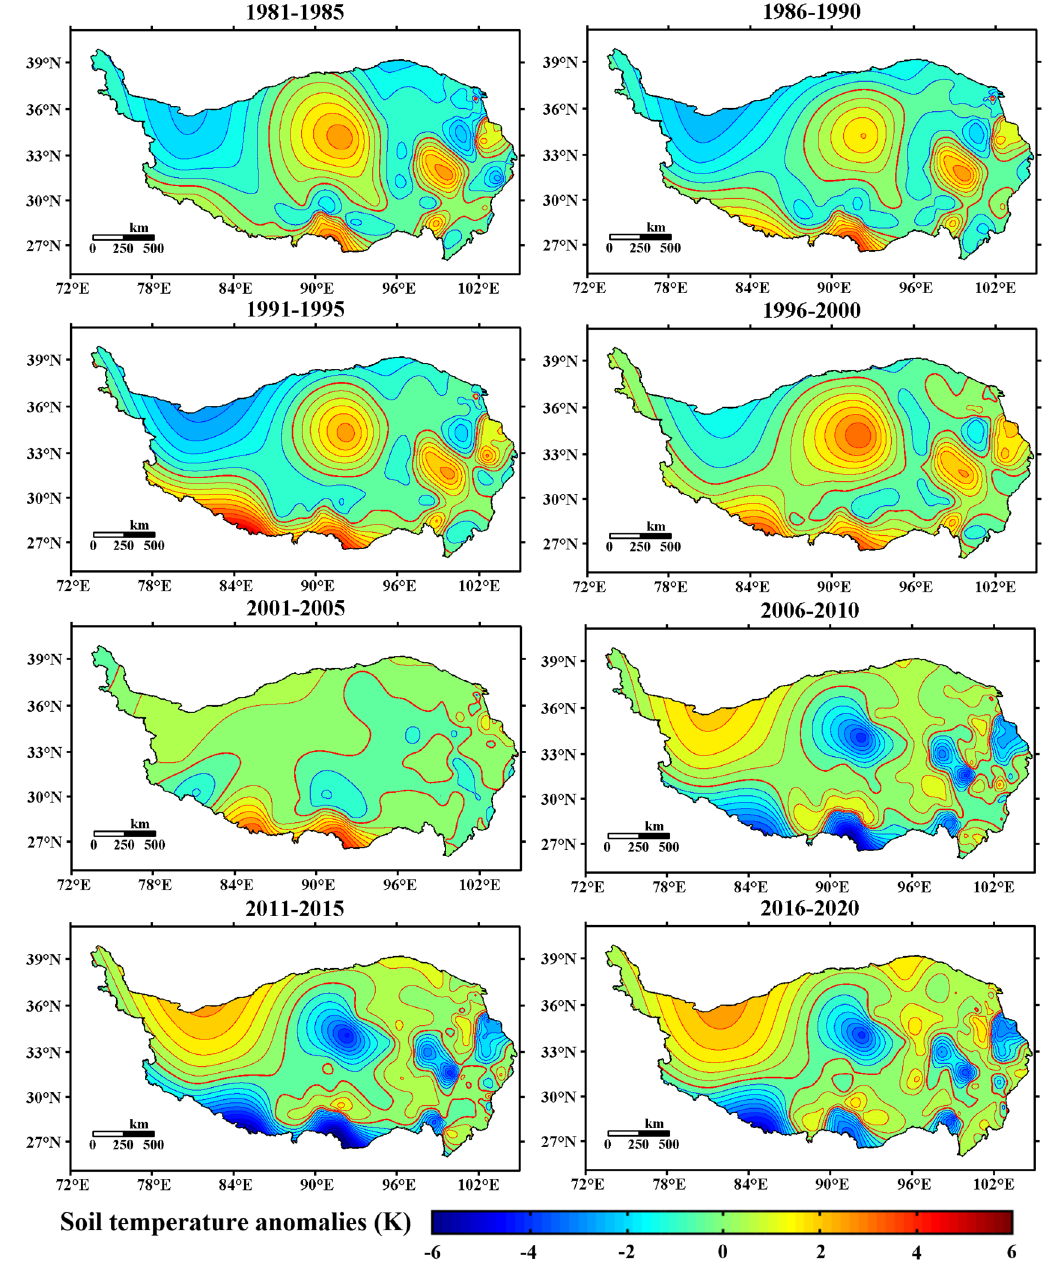
Figure 10. Spatial distribution of the 20 cm ST anomalies in the Qinghai-Tibet Plateau from 1981 to 2020 (average per five years, unit: K, Software: MATLAB 2014, https:// ww2. mathw orks. cn/ produ cts/ matlab.